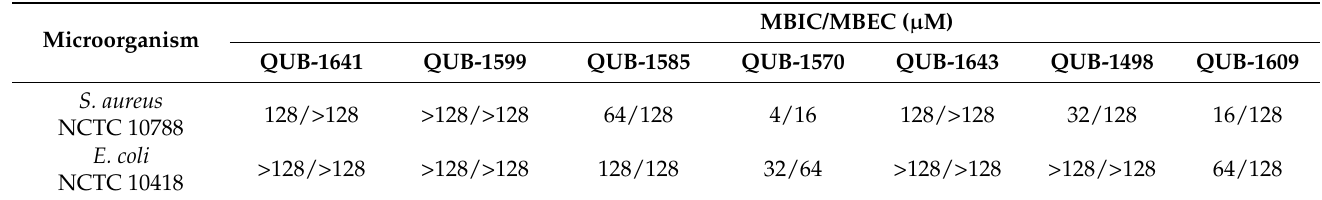
Table 4. Anti-biofilm activity of kassporin-KS1 (QUB-1641) and its analogues against S. aureus and E. coli